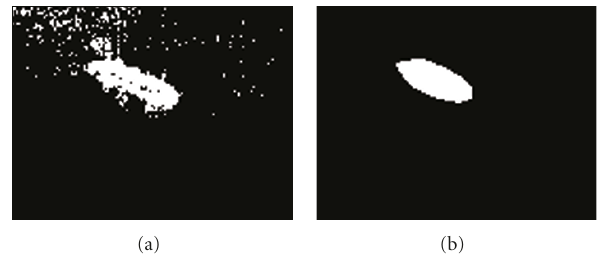
Figure 6: E ff ect of parameter μ on an AIRSAR image, size: 101 × 133. (a) Result with μ = 1, and (b) result with μ = 80.